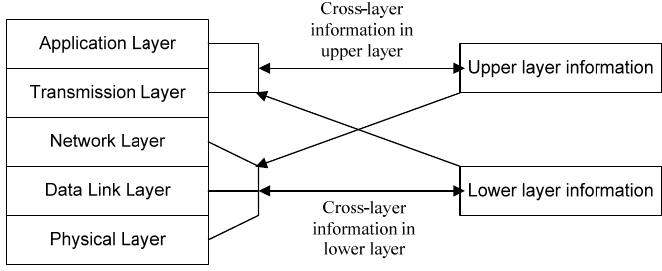
Figure 2. The principle of cross-layer design.